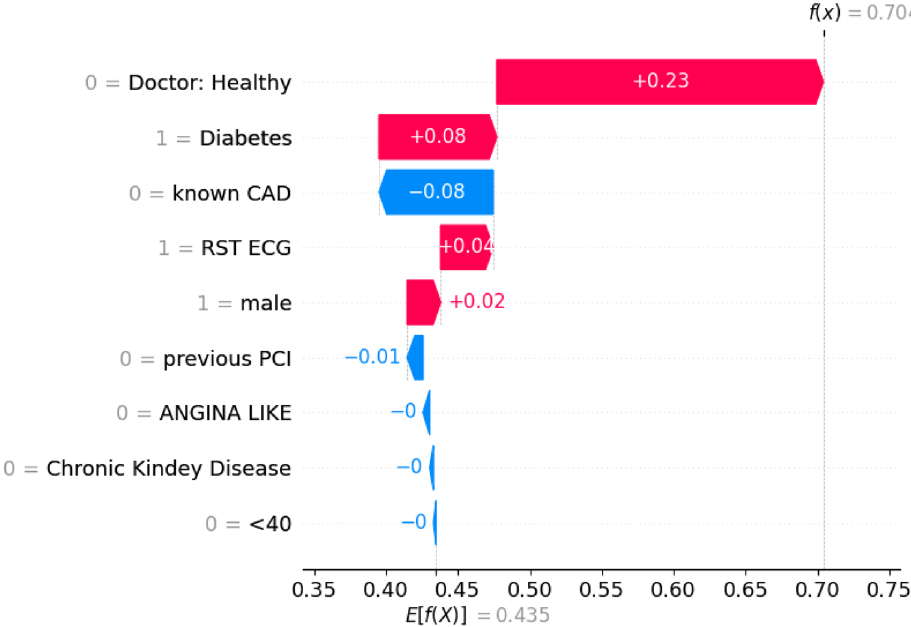
Figure 4. Waterfall diagram for a prediction of a CAD positive patient. This diagram indicates which features drove the algorithm to predict the entry as CAD. The expert had correctly identified this as a CAD instance and ICA confirmed